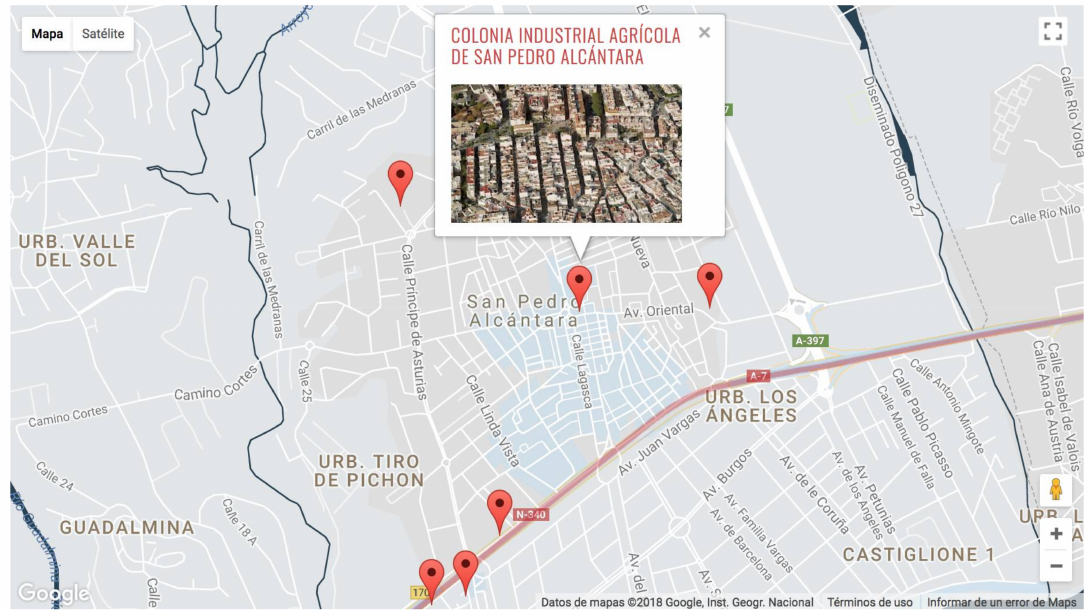
Figure 13. Viewing a sequence/group of items. “Conjuntos” and “Secuencias” are groups of items that can be viewed together on a single Google Map. This screenshot shows the six items that make up the “Colonia Agr í cola San Pedro Alc á ntara” (https://n-340.org/patrimonio/items-patrimoniales/malaga/ marbella/conjunto-colonia-agricola-san-pedro-de-alcantara/). Screenshot by the N-340 research team, January